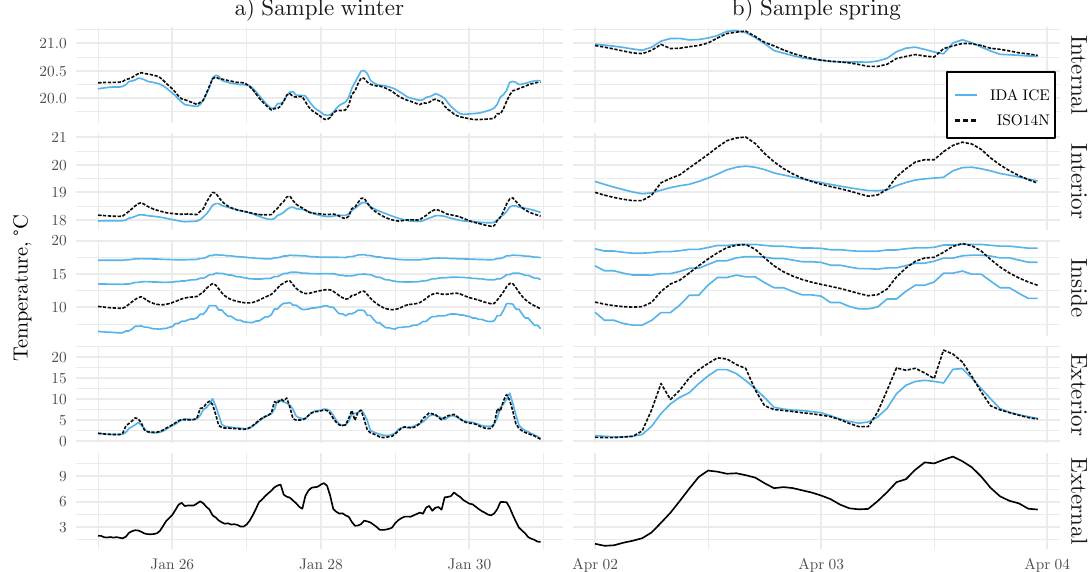
Figure 4. Comparison with IDA ICE on node temperatures for external walls. Diagram panels in column ( a ) shows a winter sample period, column; ( b ) shows a spring sample period. Diagram panel rows, from uppermost to lowermost: internal air nodes; interior surface nodes; inside nodes (one for ISO14N and three for IDA ICE); exterior surface nodes; and external air